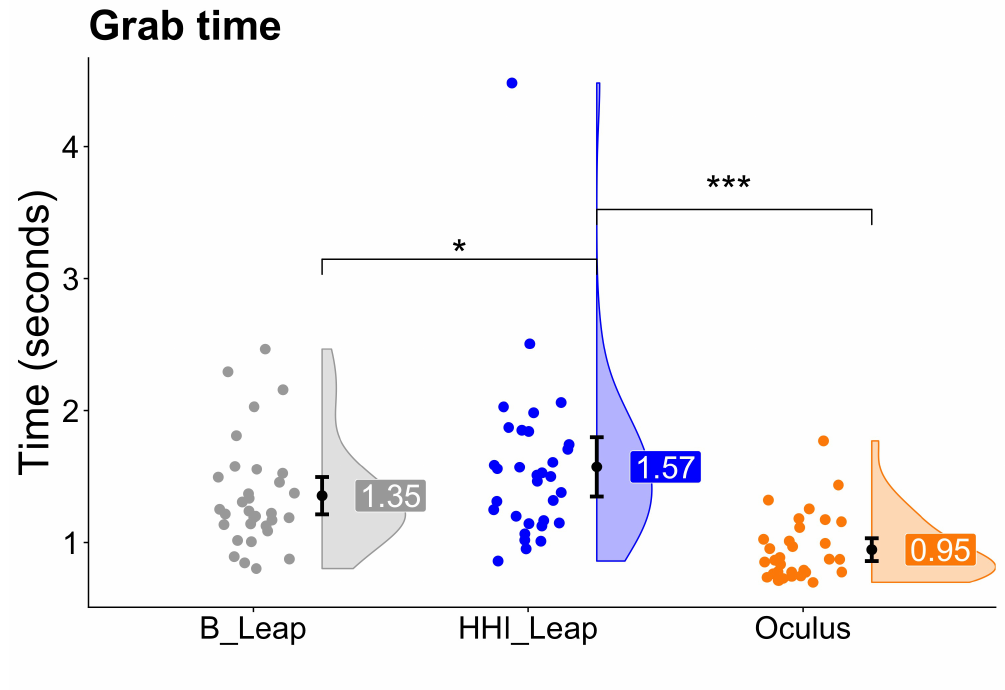
Figure 6. Grab time by interface, with means and 95% confidence intervals, individual participant times (colored dots), smoothed density distributions and results of paired-samples t -tests. * = p < 0.05, *** = p < 0.001.